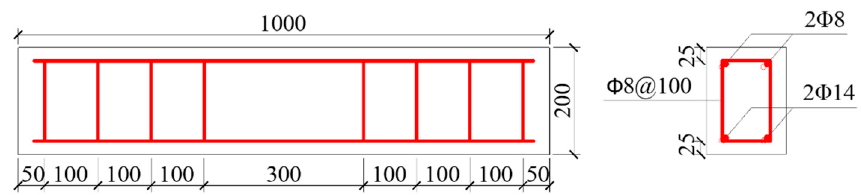
Figure 2. Layout of the reinforced concrete (RC) beams (all dimensions in mm).